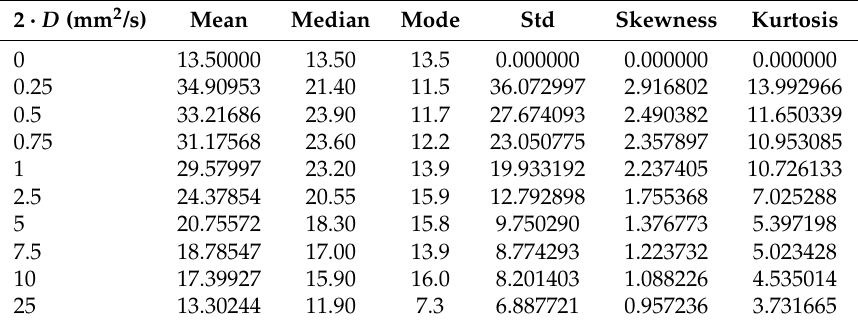
Statistics for the timing of brine shrimp agents entering the green zone by diffusivity. All values are given in units of seconds, and both skewness and kurtosis are calculated as Pearson standardized moments.